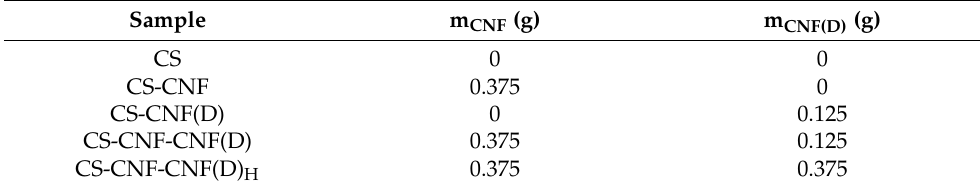
Table 1. Membrane sample names and corresponding filler